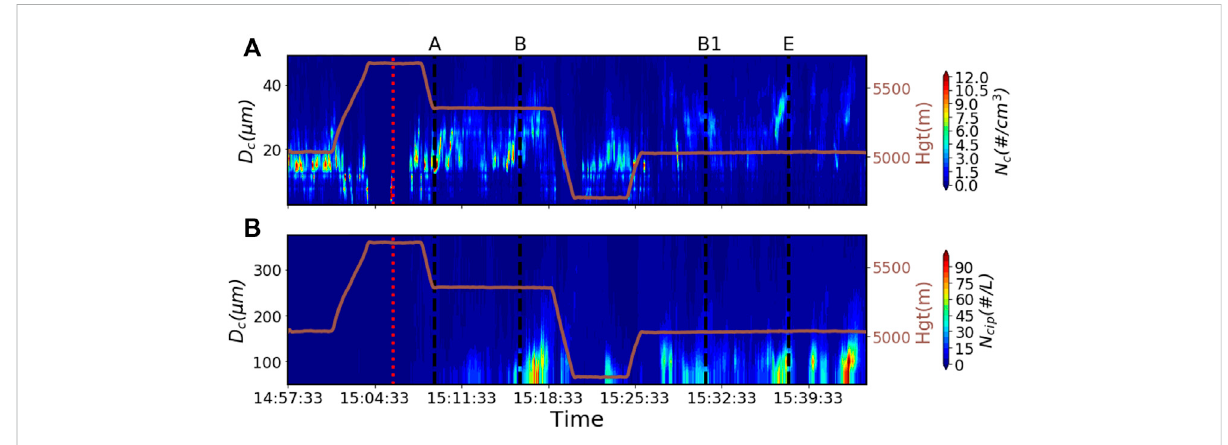
FIGURE 10 Time series of (A) cloud droplet effective diameter ( D c , µm),